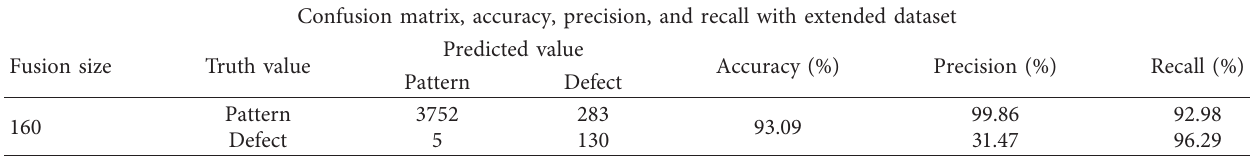
Table 4: Defect detection result using extended dataset.